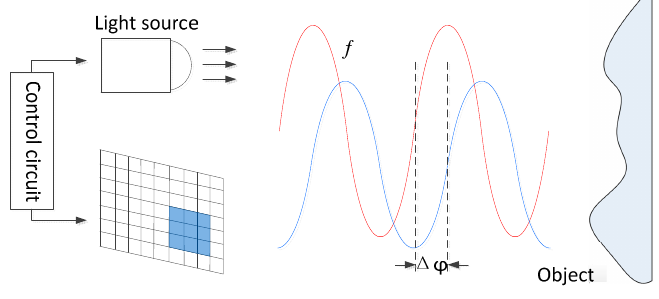
Figure 2. Principle of ToF cameras.